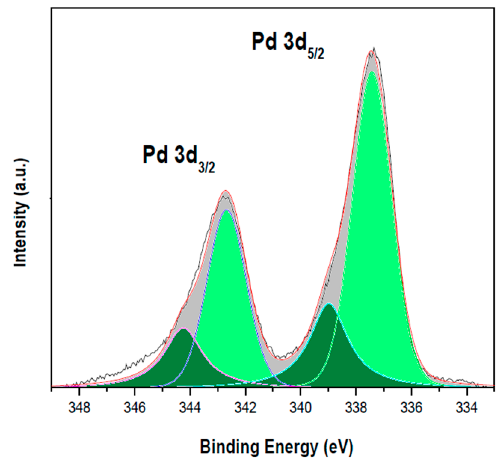
Figure 4. X-ray Photoelectron Spectroscopy (XPS) spectrum in the Pd 3 d region, for colloidal nanoparticles deposited on glass. The predominant peaks, evidenced by light green color, correspond to Pd(II) oxide.